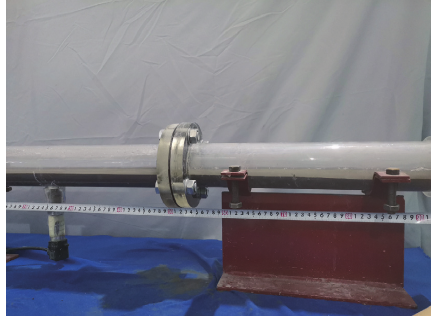
Figure 7: Backward diffusion distances of the slurry in the